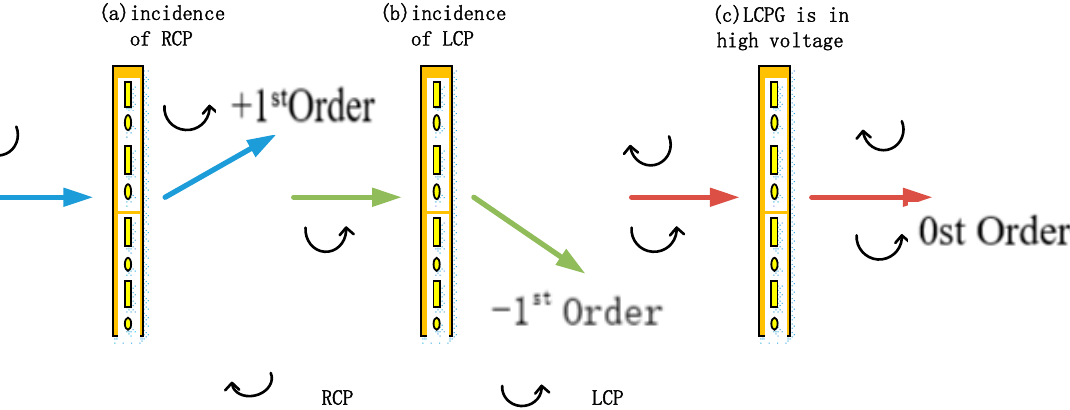
Figure 2. Diffraction characteristics of LCPG.